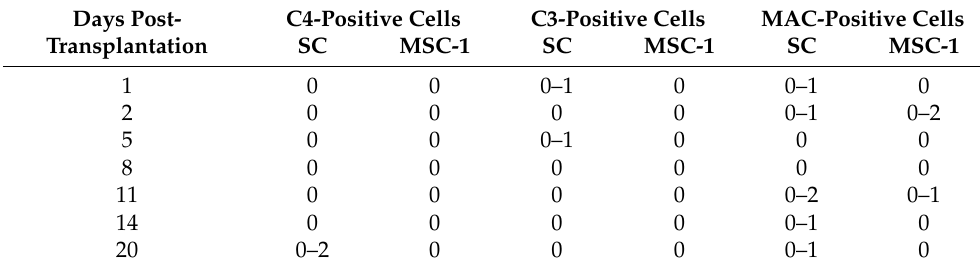
Table 2. Deposition of C4, C3, and MAC on SC and MSC-1 grafts.